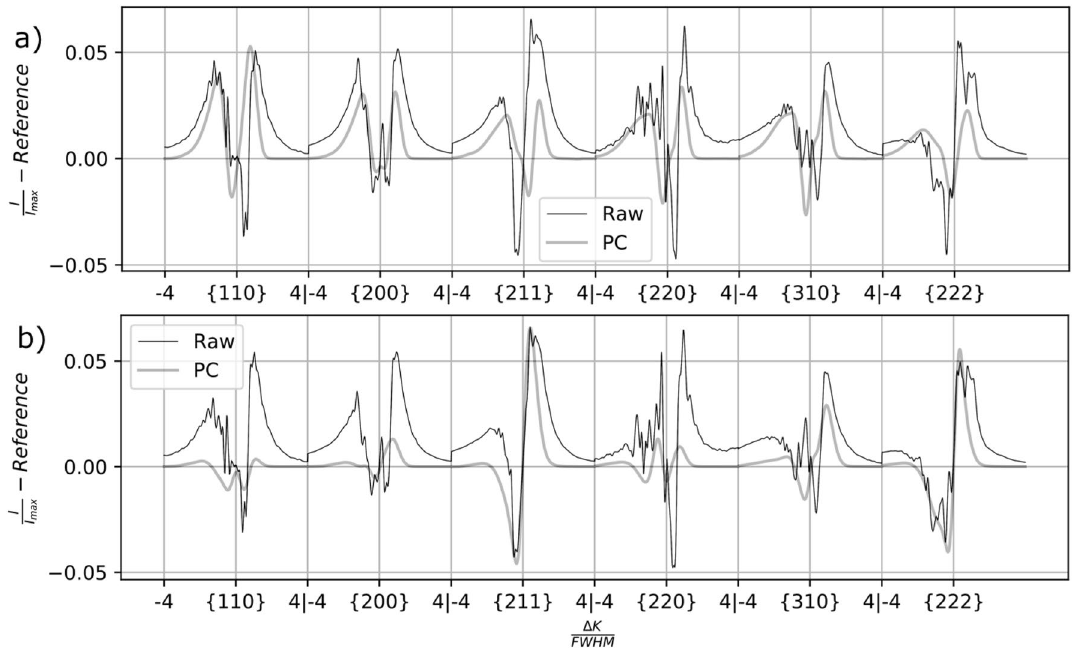
Figure 5. Actual (black) and PC (grey) representation of profile shape variation in the profile from sample IP9.3, based on ( a ) the S-W virtual diffraction algorithm and ( b ) the ǫ